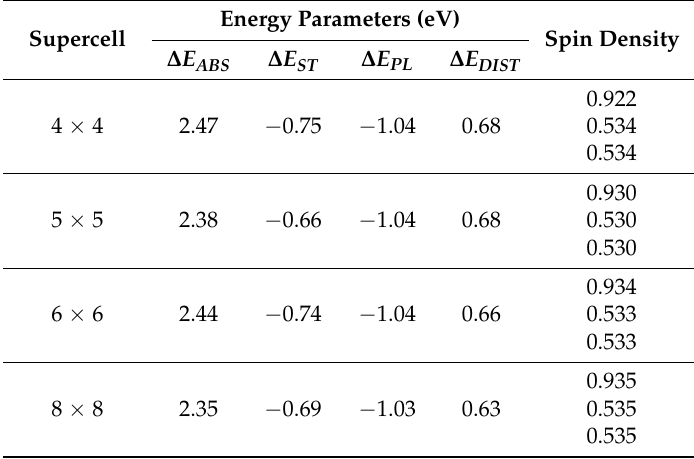
Table 2. Comparison of the energy parameters and spin density for the intermediates involved in the processes schematically described in Figure 8 for different supercells using the hybrid density functional calculations (HSE06/CRY14). The definition of the energy parameters is given in Section 2 of Computational details.